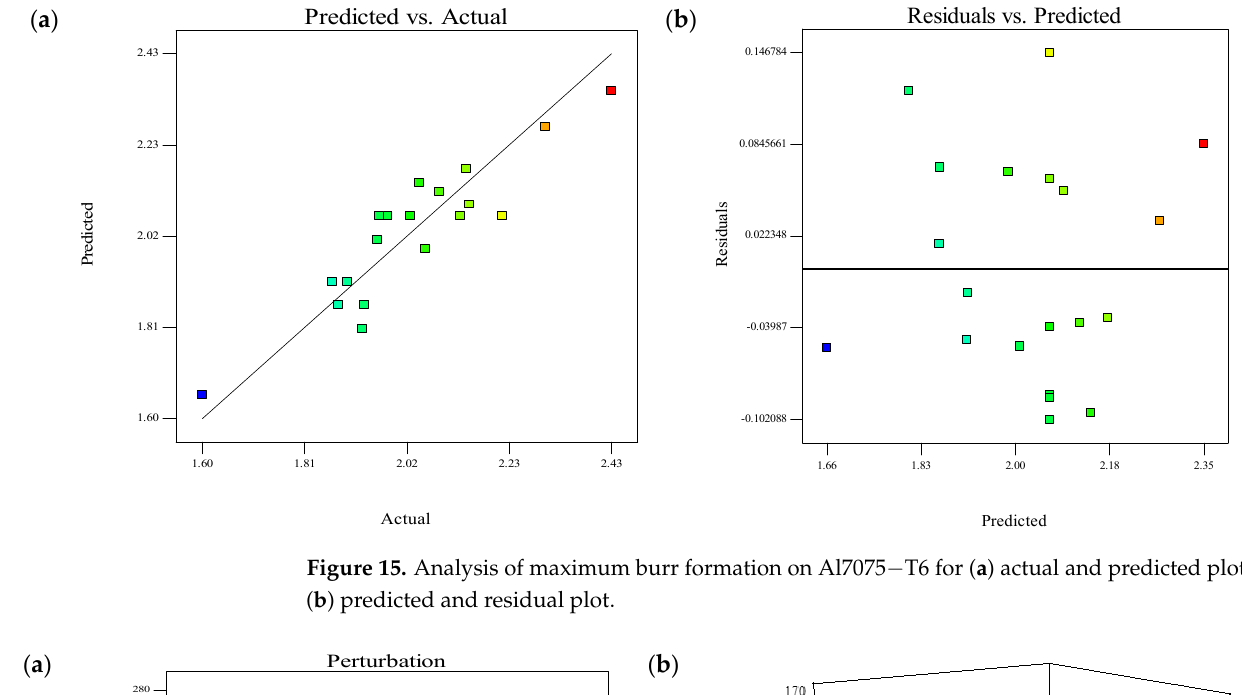
Figure 15. Analysis of maximum burr formation on Al7075 − T6 for ( a ) actual and predicted plot and ( b ) predicted and residual plot.